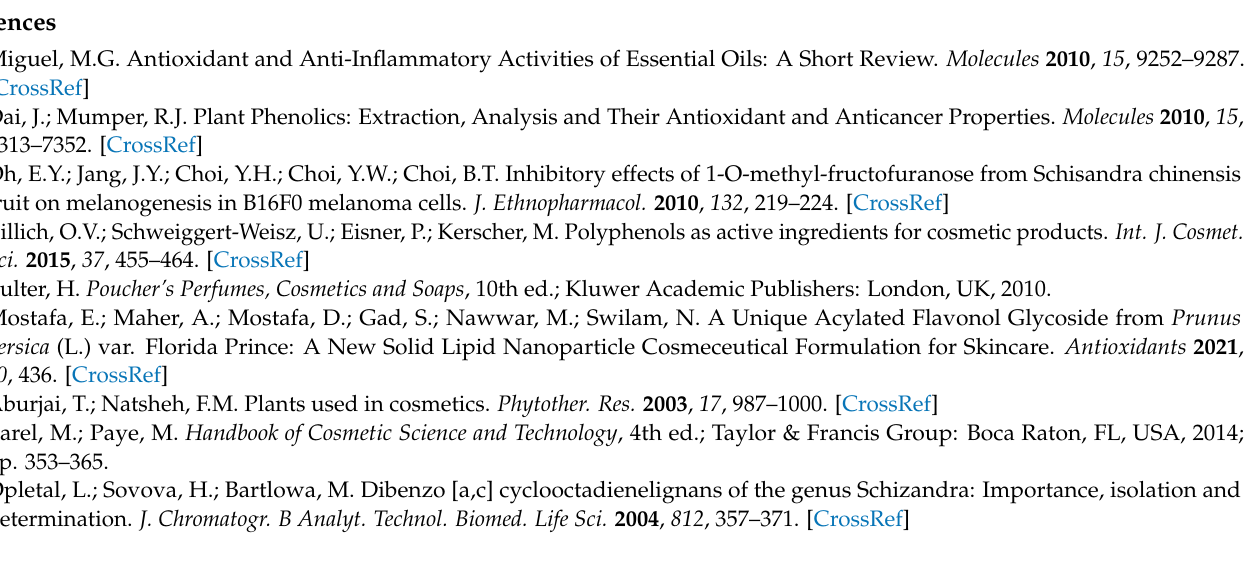
Figure S4: Representative UV-Vis spectra of compounds identified in extracts of Schisandra chinensis fruits; Figure S5: Comparison of lignans content (signal intensity) between four types of aqueous extracts of Schisandra chinensis